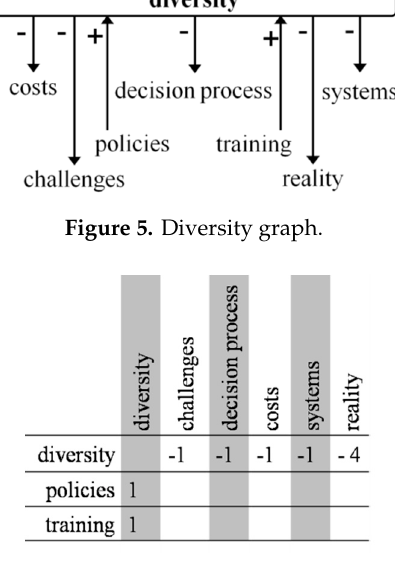
Figure 6. Diversity matrix.